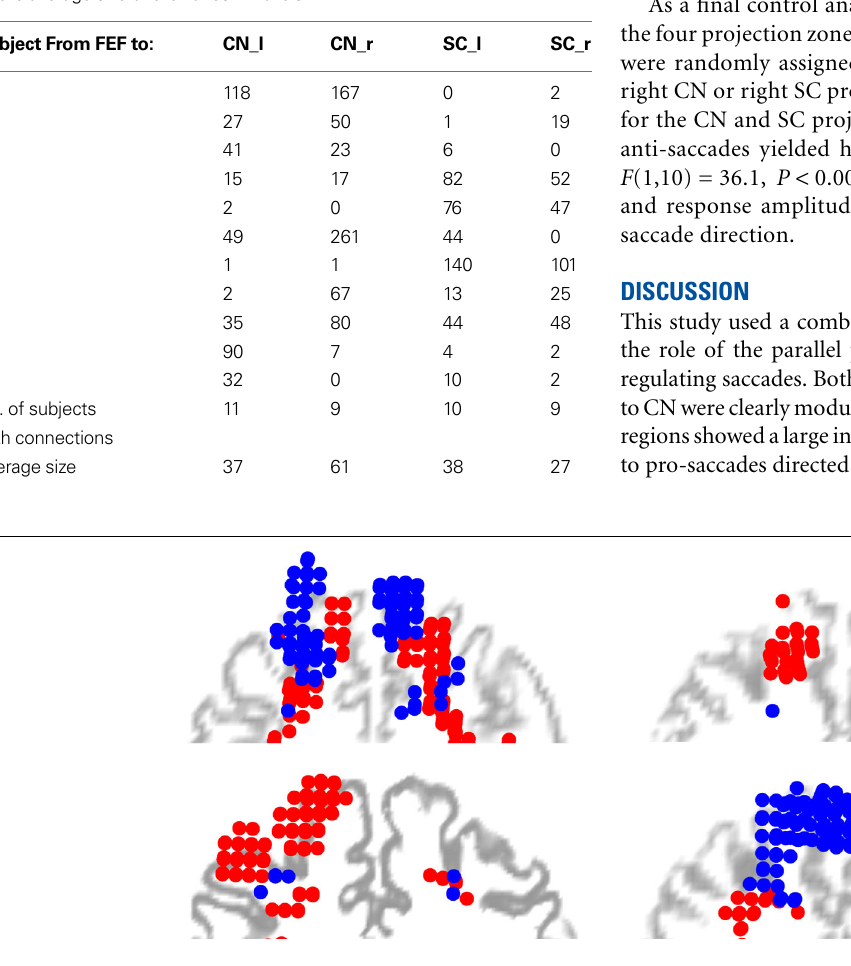
Table 1 | The amount of voxels selected per FEF projection zone, for each participant. The FEF Projection zones are defi ned as voxels uniquely connected to the ipsilateral caudate nucleus and superior colliculus: CN_l and SC_l for the left FEF, and CN_r and SC_r for the right FEF. Also, the number of subjects for which those connections could be established is given, as well as the average size of the zones in voxels.